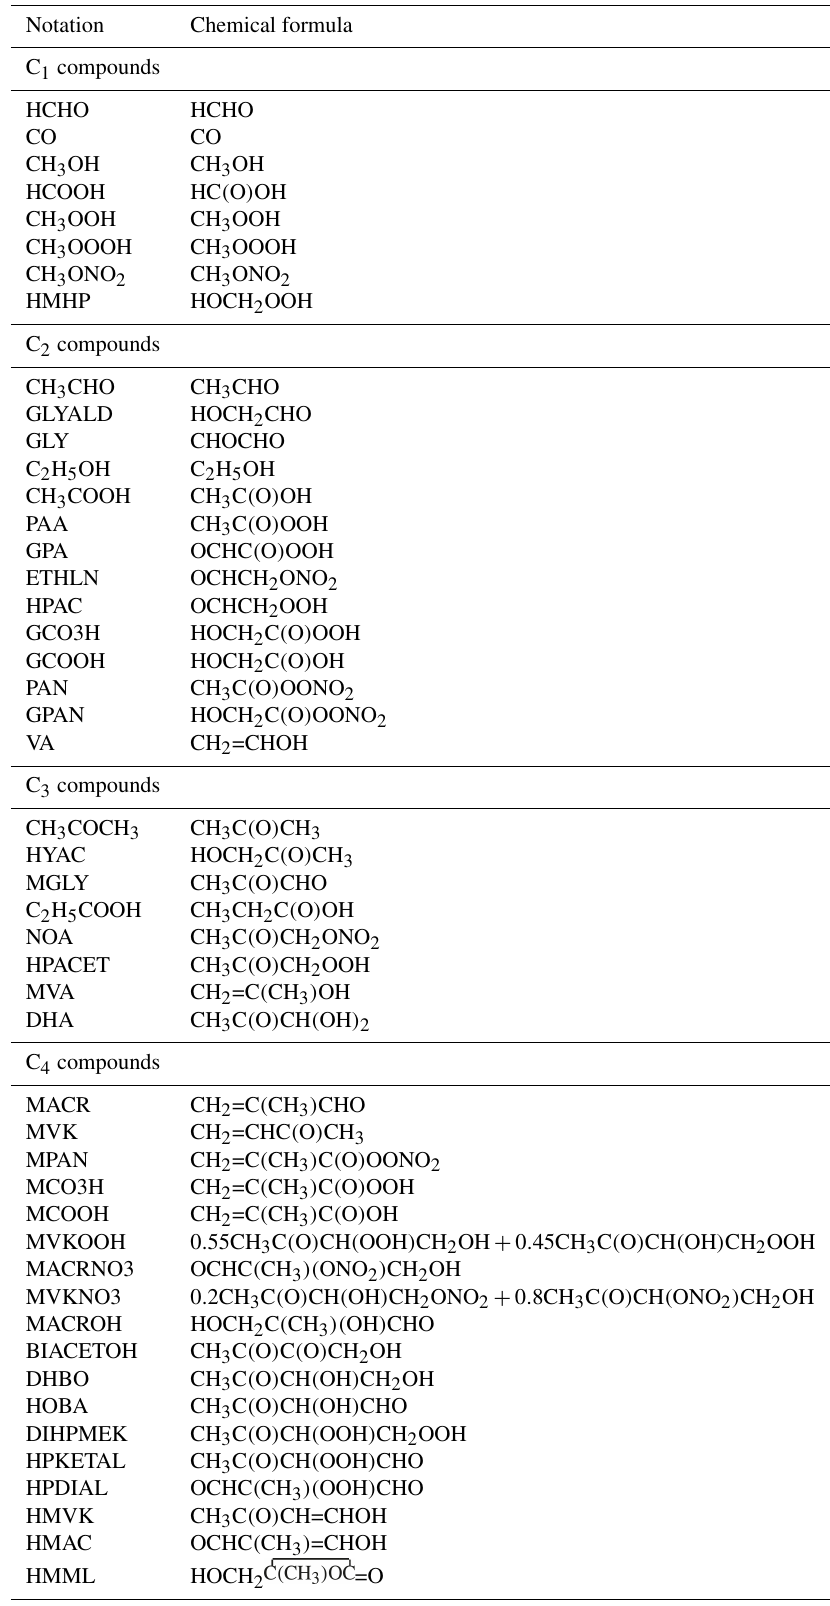
Table 1. Chemical species of the oxidation mechanism of isoprene, monoterpenes, and methylbutenol